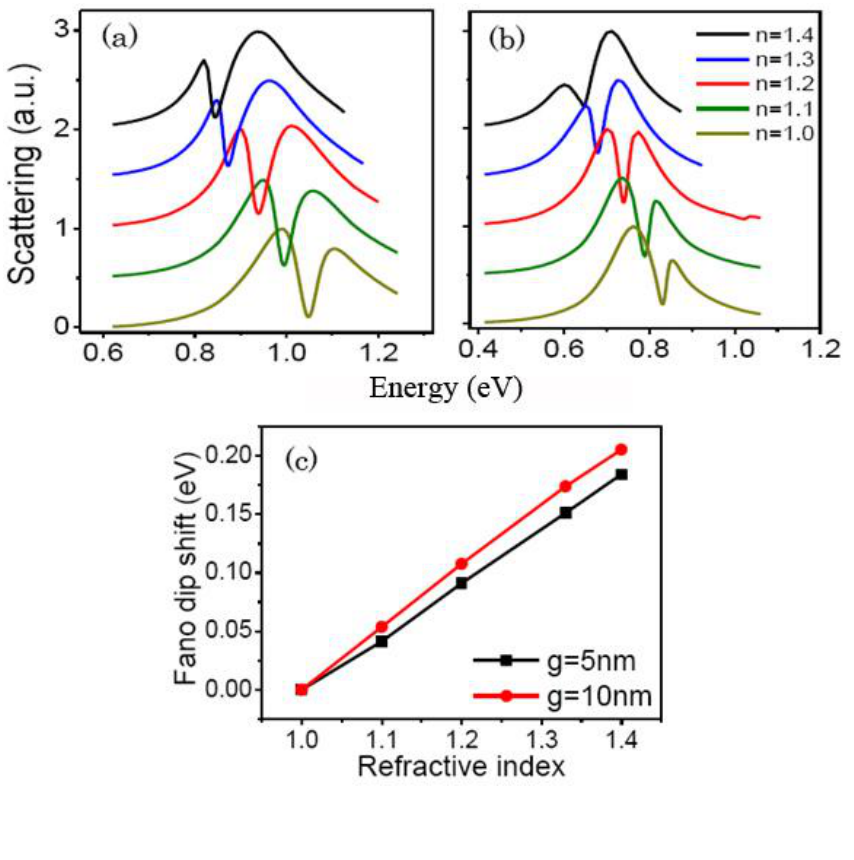
Figure 7. Scattering spectra of the RCSRD on a glass substrate surrounded by media with varying refractive indices for the gap g of 10 nm ( a ) and of 5 nm ( b ); ( c ) The Fano dip shifts with different refractive indices of surrounding dielectric